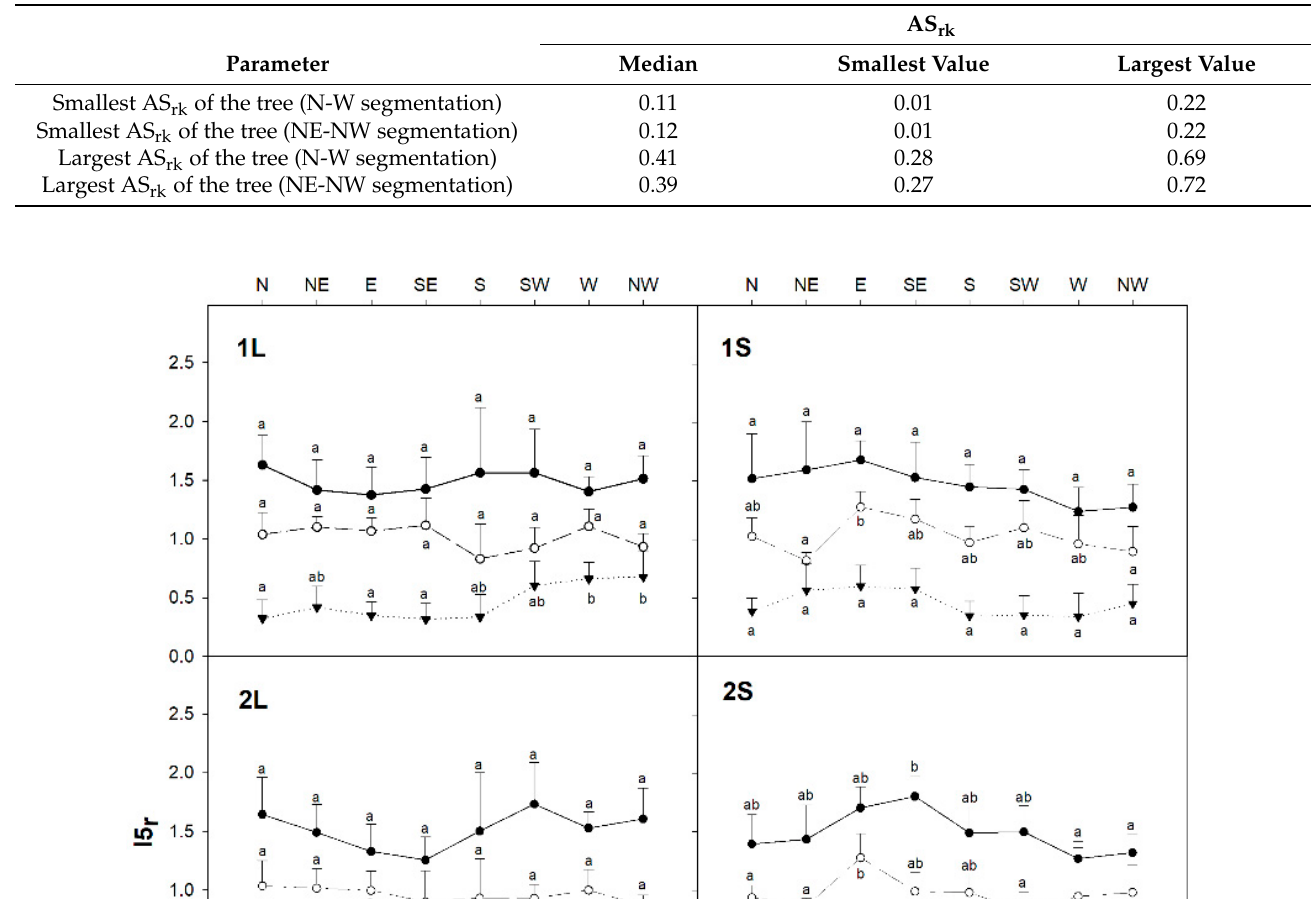
Table 2. Observed median and extremes of relative tree social area segments (AS rk ), ( n = 279).